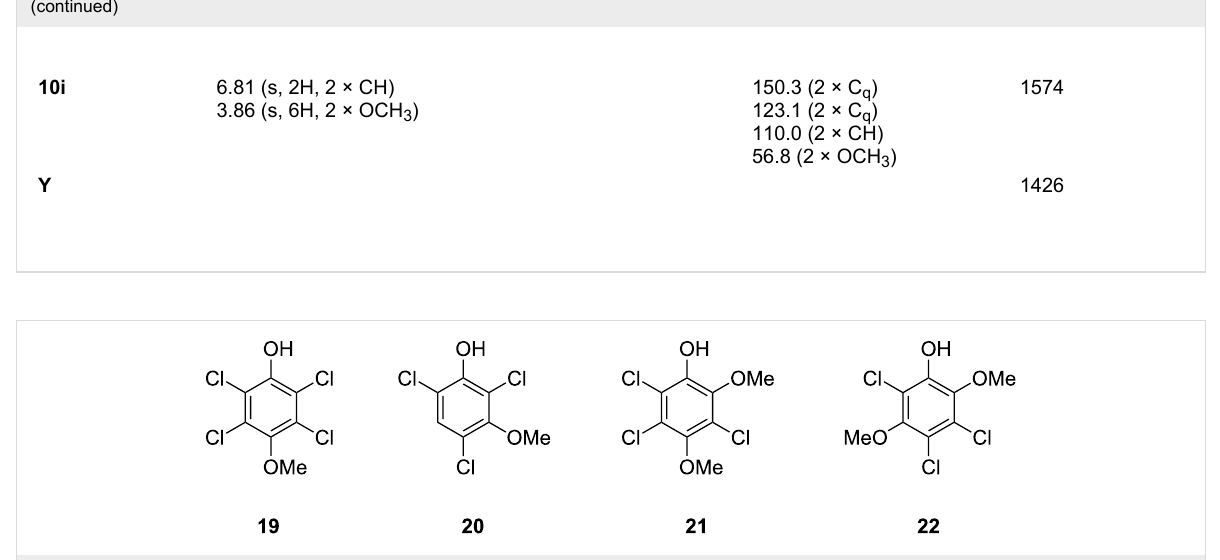
Figure 5: Known natural products that are structurally related to 4b and 10b from Geniculosporium .